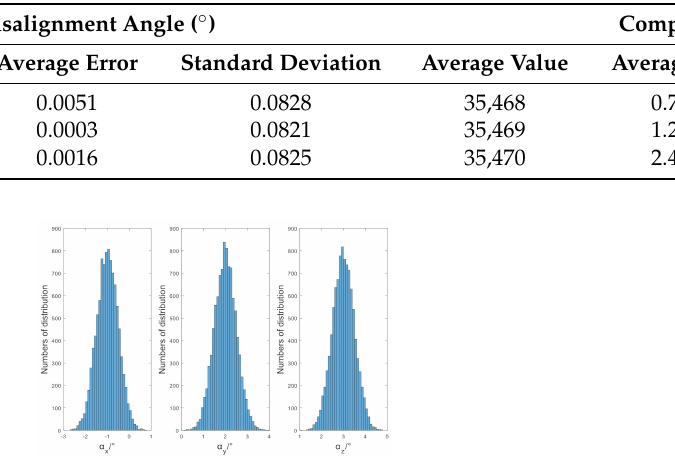
Figure 7. Simulation results of misalignment